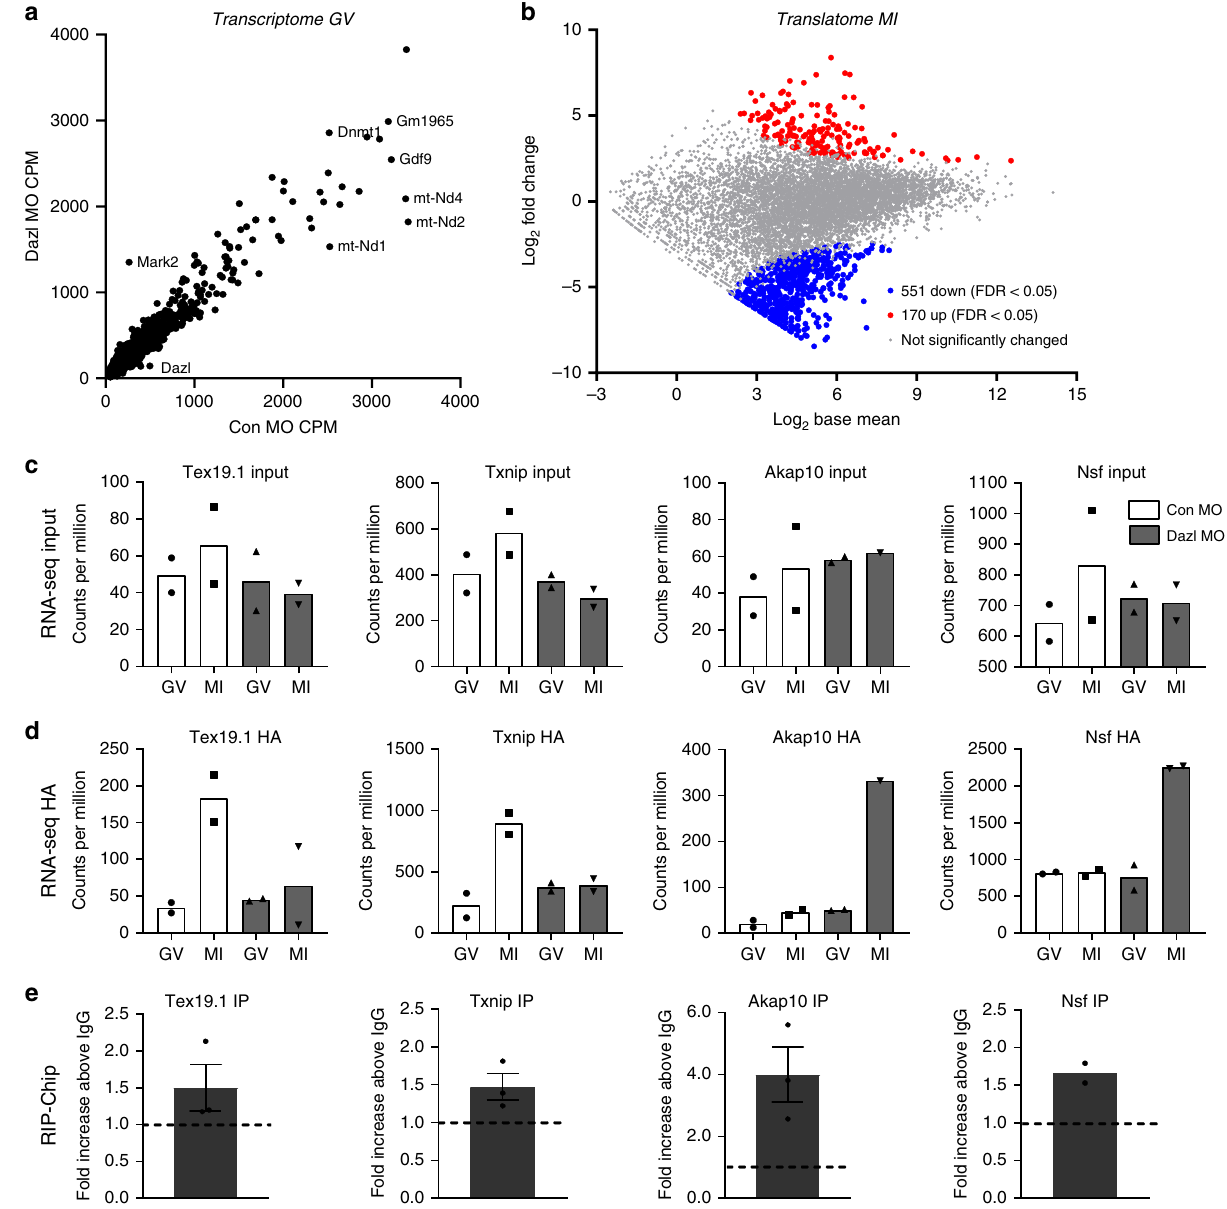
Fig. 2 Maternal mRNA loading onto ribosome is disrupted in oocytes depleted of DAZL. a Comparison of transcriptomes of MO injected oocytes. Oocytes from RiboTag fl / fl :Zp3-Cre:WT mice were injected with a CON-MO whereas oocytes from RiboTag fl / fl :Zp3-Cre:Dazl + / − mice were injected with a DAZL-MO. Oocytes were preincubated overnight in the presence of milrinone and the following morning were collected for RiboTag IP/RNA-Seq as described in the “ Methods ” . The average counts per million reads (CPM) for input (total transcripts) from two biological replicates is reported. b Comparison of transcripts recovered by RiboTag IP/RNA-Seq in Control and DAZL-MO injected oocytes (MI). GV stage oocytes from RiboTag fl / fl :Zp3- Cre:WT or RiboTag fl / fl :Zp3-Cre : Dazl + / − mice were injected with CON-MO or DAZL-MO. After overnight preincubation with 2 µ M milrinone, oocytes were cultured in inhibitor-free medium to allow reentry into the meiotic cell cycle. Oocytes were collected at 6 h for RiboTag IP and RNA-Seq analysis as detailed in the methods. Ribosome loading of signi fi cantly decreased transcripts (551 transcripts; FDR < 0.05, 2-fold change) is reported in blue, while ribosome loading of transcripts signi fi cantly increased (170 transcripts; FDR < 0.05, 2-fold change) after DAZL removal is reported in red. Transcripts not signi fi cantly changed are depicted in grey. Two independent biological samples were used in this analysis. c – e Effect of DAZL depletion on total RNA levels and ribosome loading of representative DAZL interacting targets. c , d GV stage oocytes from RiboTag fl / fl :Zp3-Cre:WT or RiboTag fl / fl :Zp3-Cre:Dazl + / − mice were injected with CON-MO or DAZL-MO. The experimental conditions and data from analysis are as in b . The bar represents the mean and each dot represents the CPM from the two biological replicatesRNA-Seq data from supernatants (input) before IP ( c ) and RiboTag IP of CON-MO and DAZL-MO ( d ) are reported. e DAZL RIP-Chip of oocyte extracts of selected mRNAs is reported as the fold enrichment DAZL AB/IgG; Data are presented as mean values ±SEM of three biologically independent samples except for NSF1 where N =